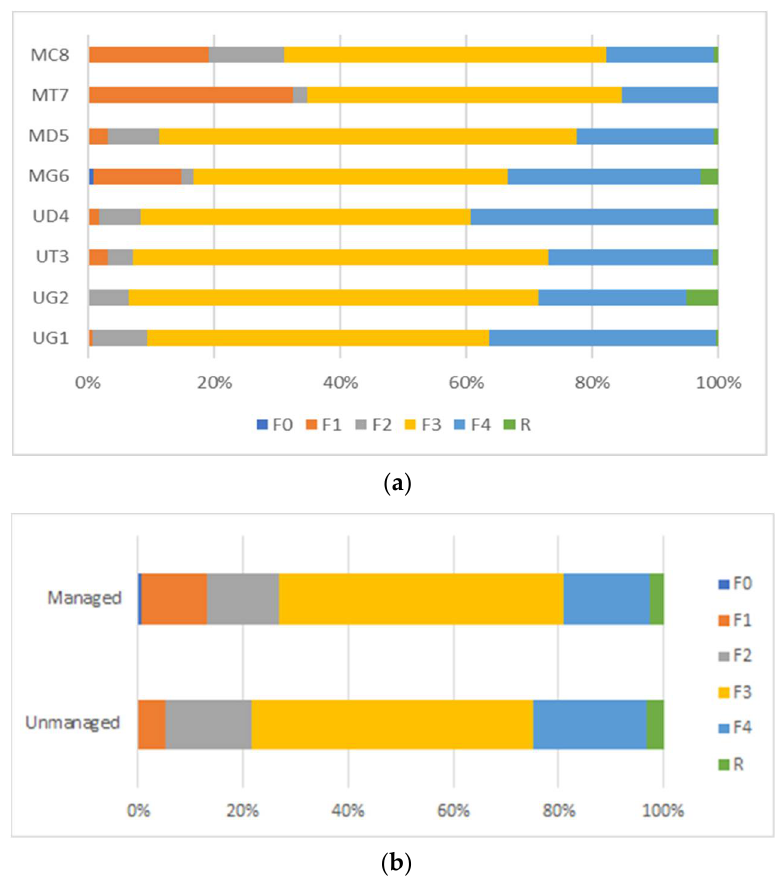
Figure 3. Percentage shares of species in terms of fidelity classes in analysed managed and unman- aged pine stands in western Poland ( a ); percentage shares of species depending on fidelity classes in managed and unmanaged pine stands in western Poland ( b ).